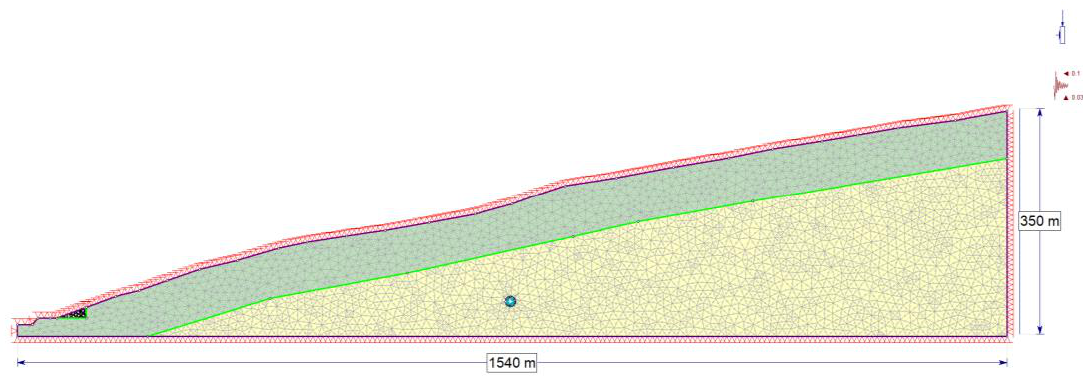
Figure 20. Boundary conditions of 2D model for determining the tunnel excavation and support systems.